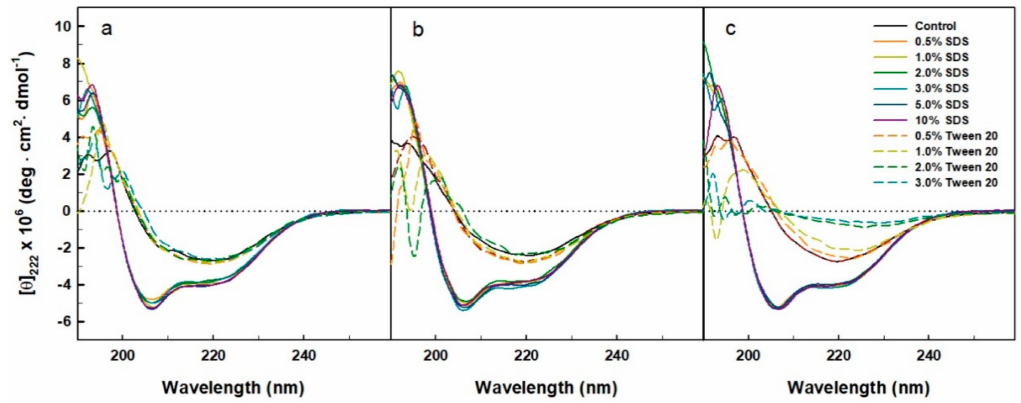
Figure 5. Far-UV CD spectra of His 6 -tagged Bd PTE in the absence and presence of surfactants. Spectral analyses were carried out after one-hour incubation of the enzyme samples at ambient temperature ( a ), 40 ◦ C ( b ), and 60 ◦ C ( c ), respectively, for 1